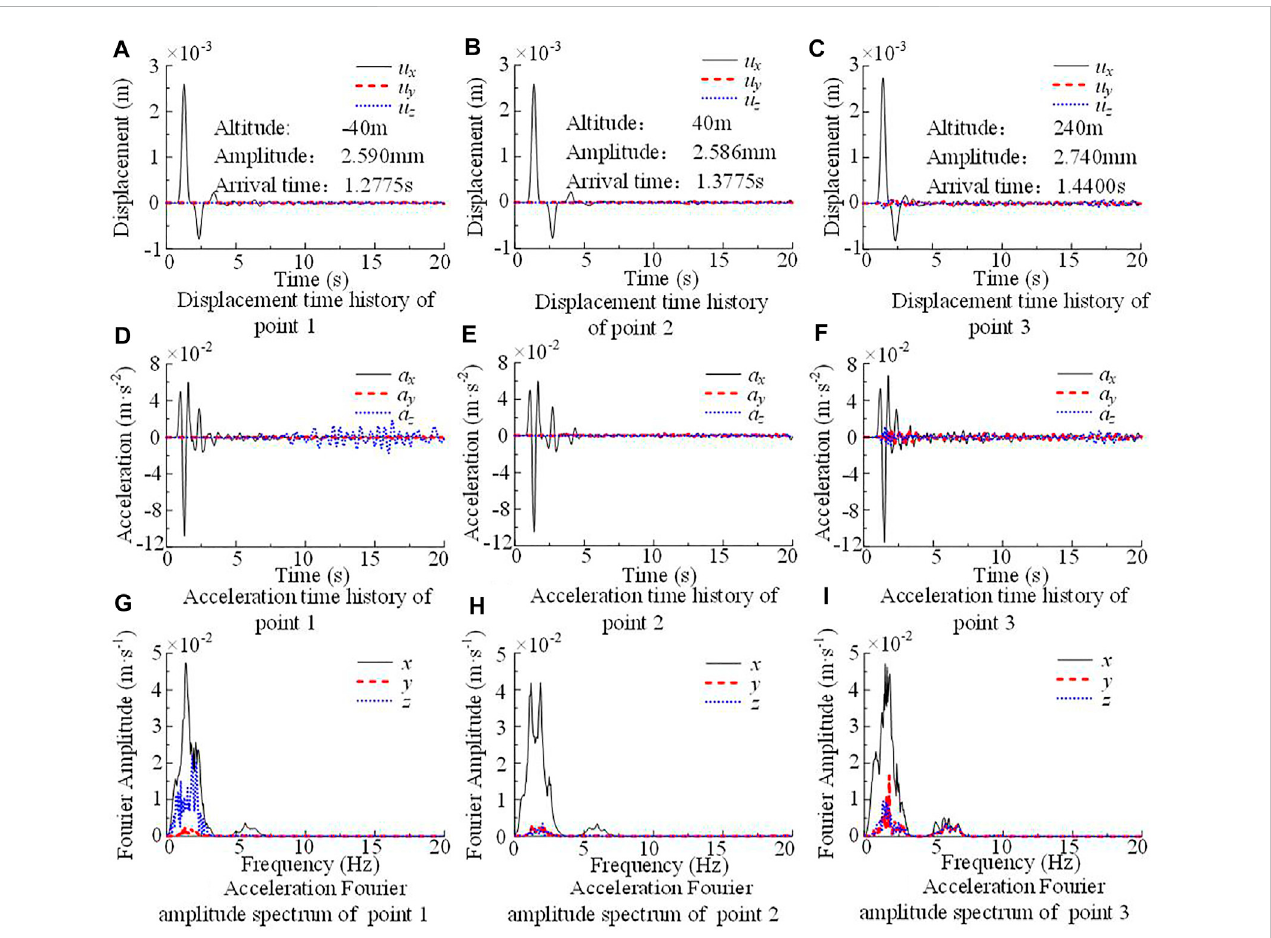
FIGURE 13 Displacement, acceleration time history curve and acceleration Fourier spectrum of observation points with SV-wave input.